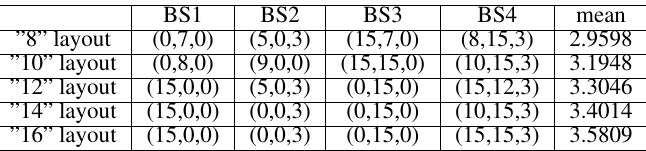
Table 4. Optimal layout base-station coordinate and its PDOP